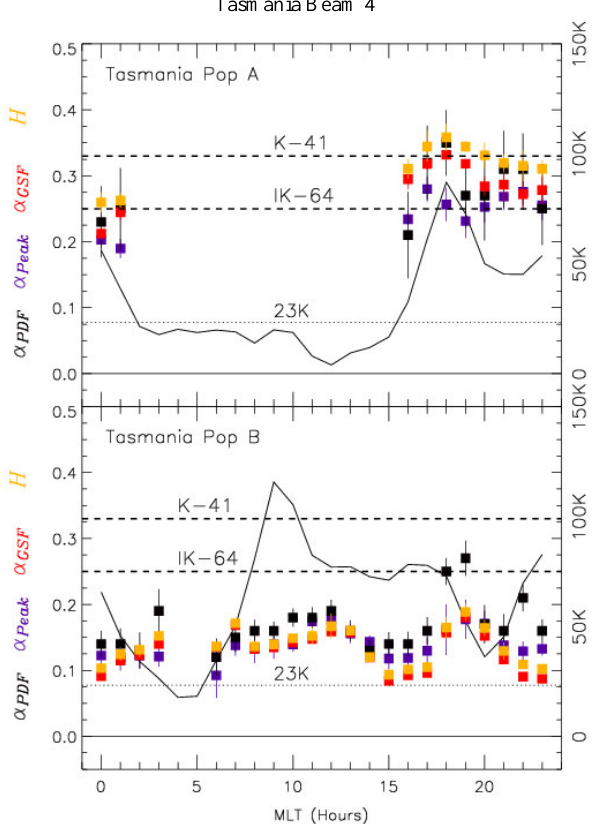
Fig. 9. (a) The variation of scaling exponents α PDF (black), α Peak (purple) α GSF (red), and H (orange) with MLT for Population A echoes measured using Tasmania beam 4. The α PDF results are shown for τ =64 to 256s. All other scaling exponents were calcu- lated using the quasi-linear regimes identified between τ ∼ 8s and ∼ 2048s (34min) in log-log plots. Error bars are at the 1 σ level and scaling exponents estimated using less than 23284 samples were re- jected. (b) The same except for Population B echoes. In both parts, the continuous curves show the number of δ v los samples identified at τ =1s, with corresponding labels at right (e.g. 50K=50000 sam-